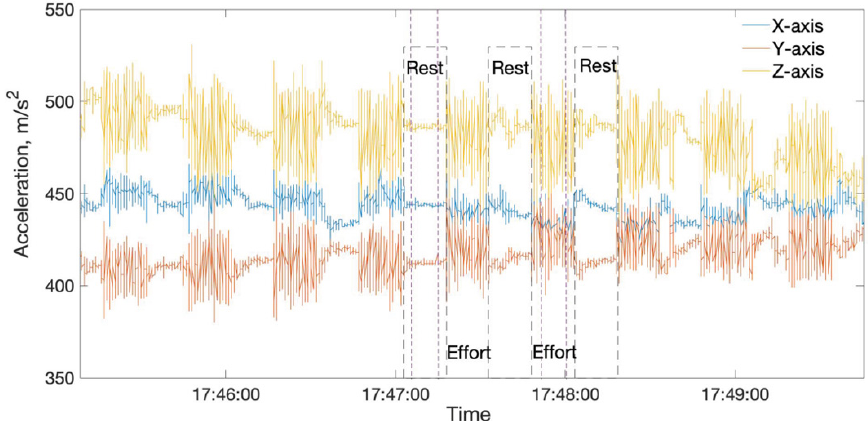
Figure 1. Effort and rest task data (middle 10 s of each event was taken for the analysis). Figure 1. E ff ort and rest task data (middle 10 s of each event was taken for the